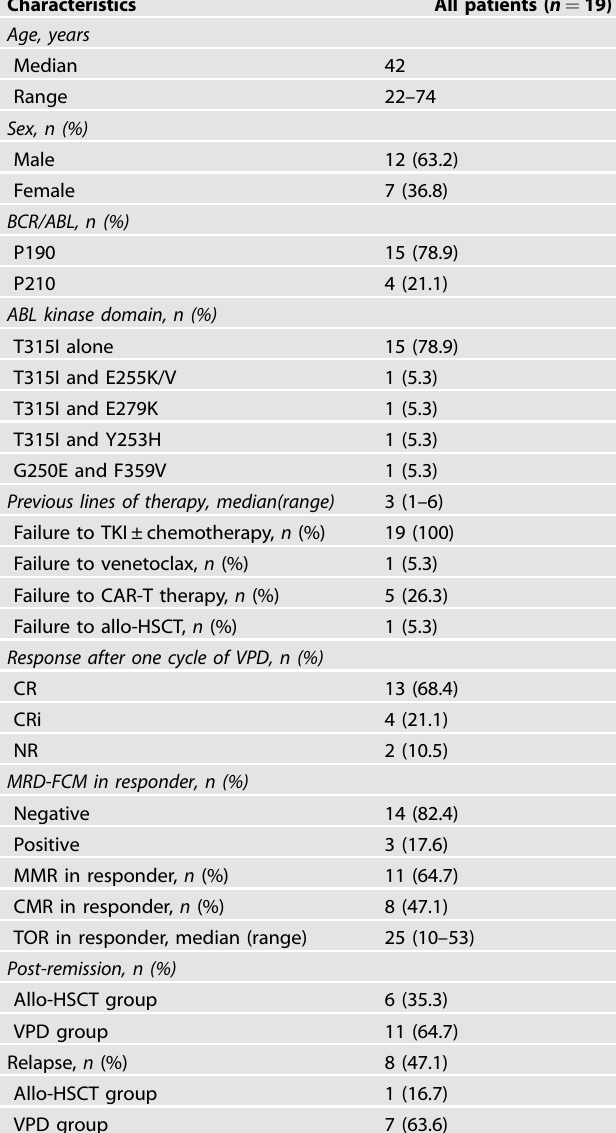
Table 1. Baseline characteristics of Ph + ALL